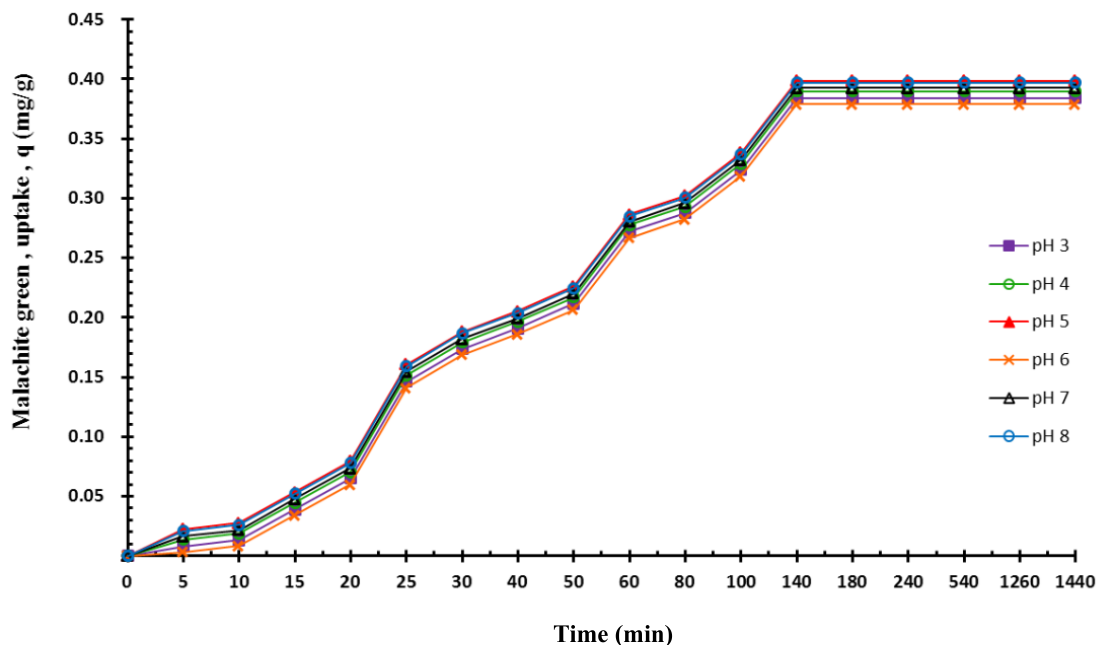
centrifugal tube, agitation speed = 125